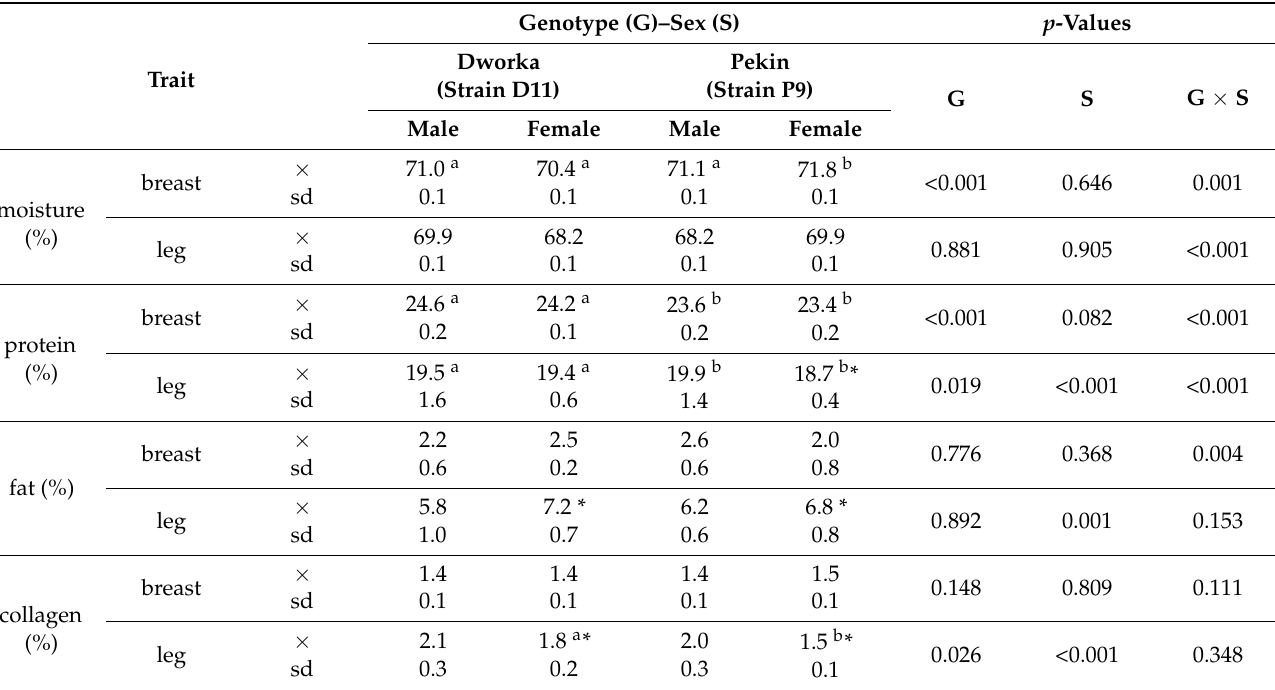
Table 2. Mean values ( × ) and standard deviation (sd) of the chemical composition of the pectoral muscles and legs of 113-week-old